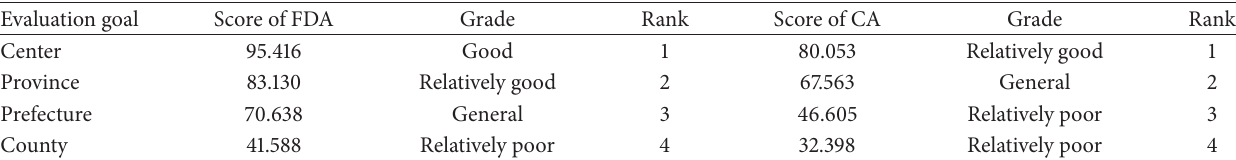
Table 9: Scores of different administrative levels (media includes media bodies at the prefectural and county levels, but they show no specific distinction to those at the central and provincial levels; therefore, this study does not evaluate the FSSIT of media at different administrative levels.).